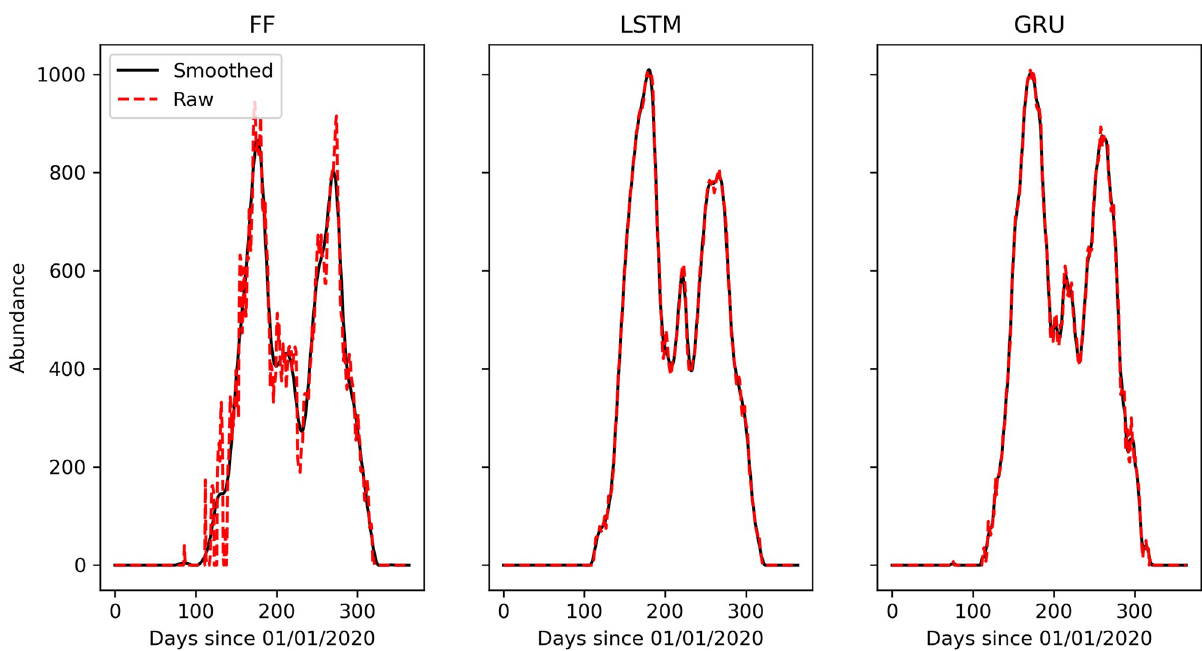
Fig 4. Comparison of the raw and smoothed abundance curves in Avondale, Arizona (2020) for the FF ( left ), LSTM ( center ), and GRU ( right ) models. Data are smoothed according to Data smoothing.